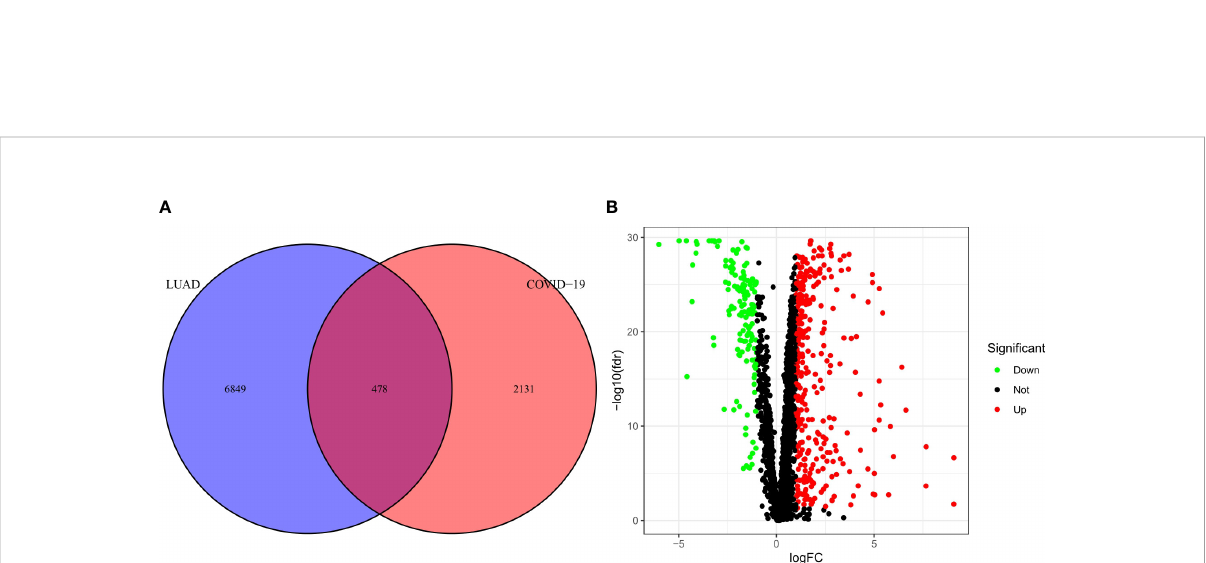
FIGURE 2 Analysis of intersecting genes in CRC/COV ID-19. (A) Venn diagram depicting intersecting genes in LUAD/COVID-19. (B) Volcano-plot representation of differential gene expression (DGE).